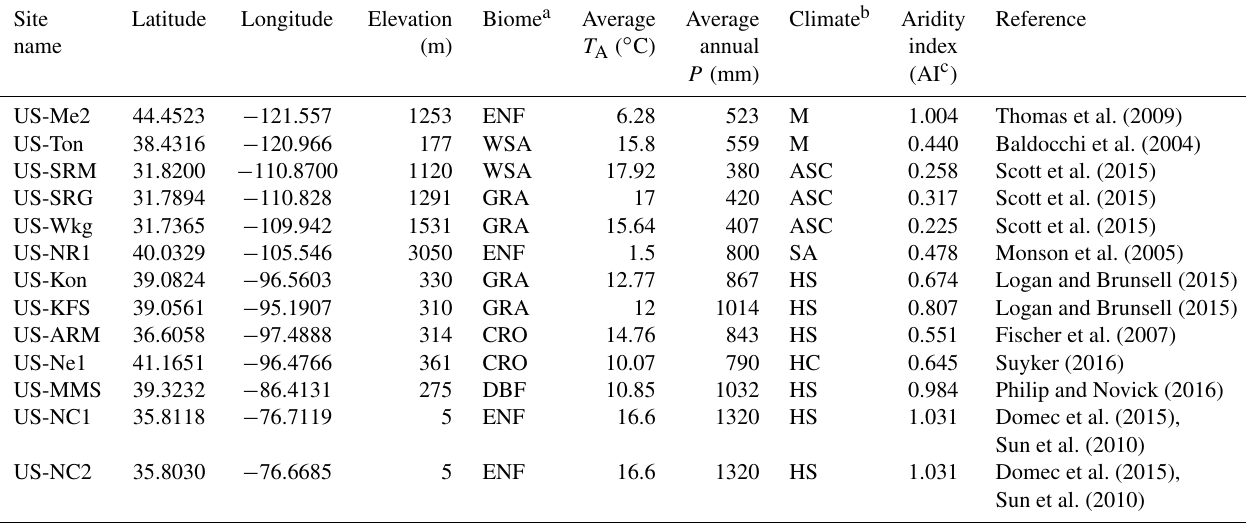
Table 1. An overview of the 13 core AmeriFlux sites used for the validation of the STIC1.2 model. Site Latitude Longitude Elevation Biome a Average Average Climate b Aridity